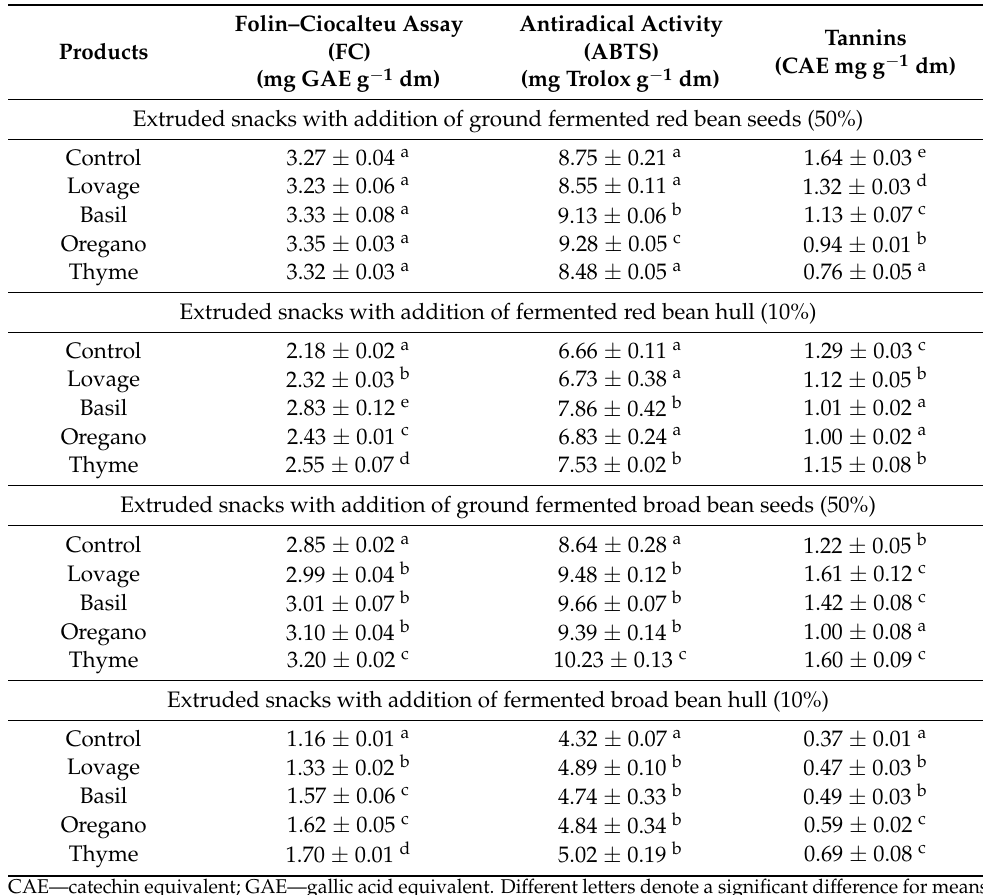
Table 3. Antioxidant activity and tannin content of extruded snacks with the addition of fermented red or broad beans/hull and with herbs/species (0.5%), and the controls (without herbs/spices